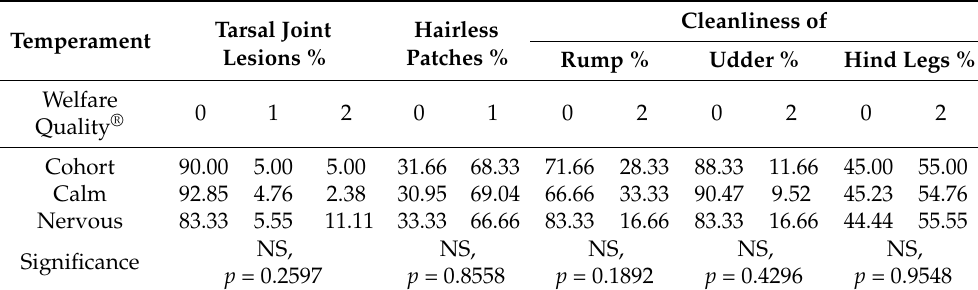
Table 3. Contingency tables for tarsal joint lesions, hairless patches, cleanliness of rump, cleanliness of udder, and cleanliness of hind legs in calm and nervous buffalo cows.